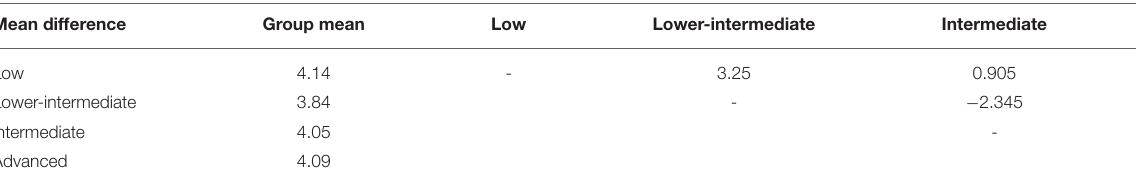
TABLE 7 | Multiple comparisons of actual achievement and FLE ( N = 90).